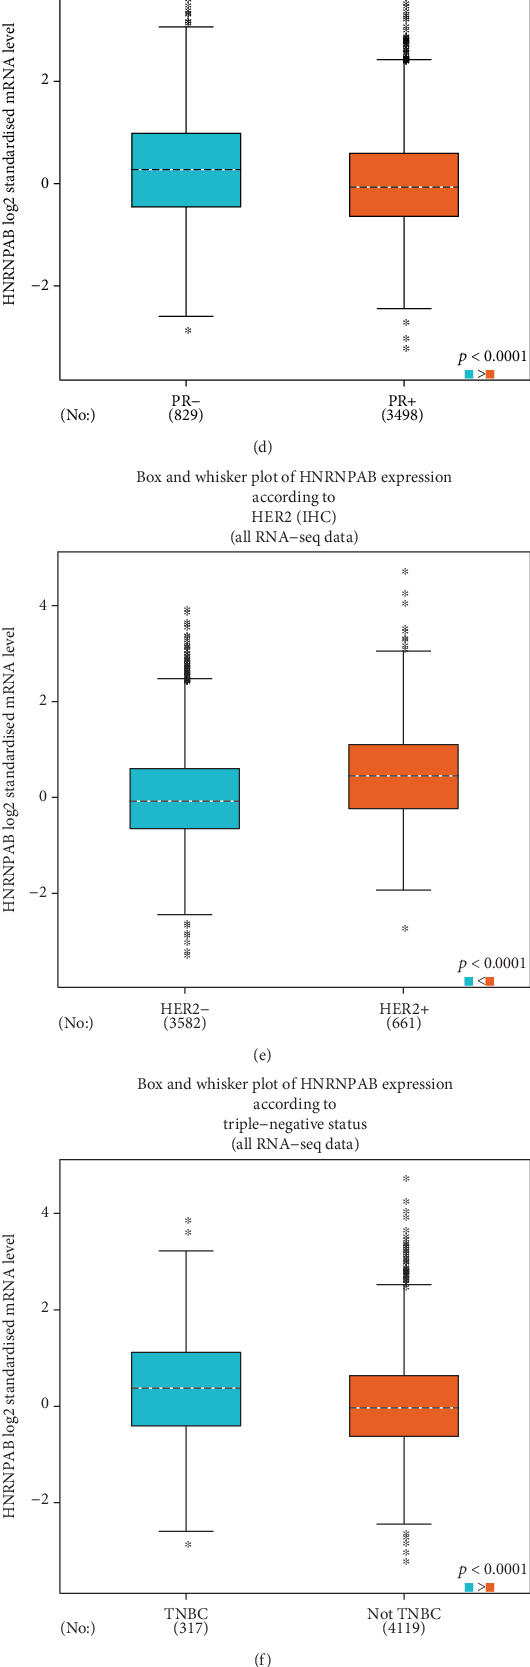
The correlations between HNRNPAB expression and clinicopathological parameters in BC patients were evaluated using bc-GenExMiner v4.3. Global significant difference between groups was determined using Welch's t-test to calculate p values, following with the Dunnett-Tukey-Kramer t-test.